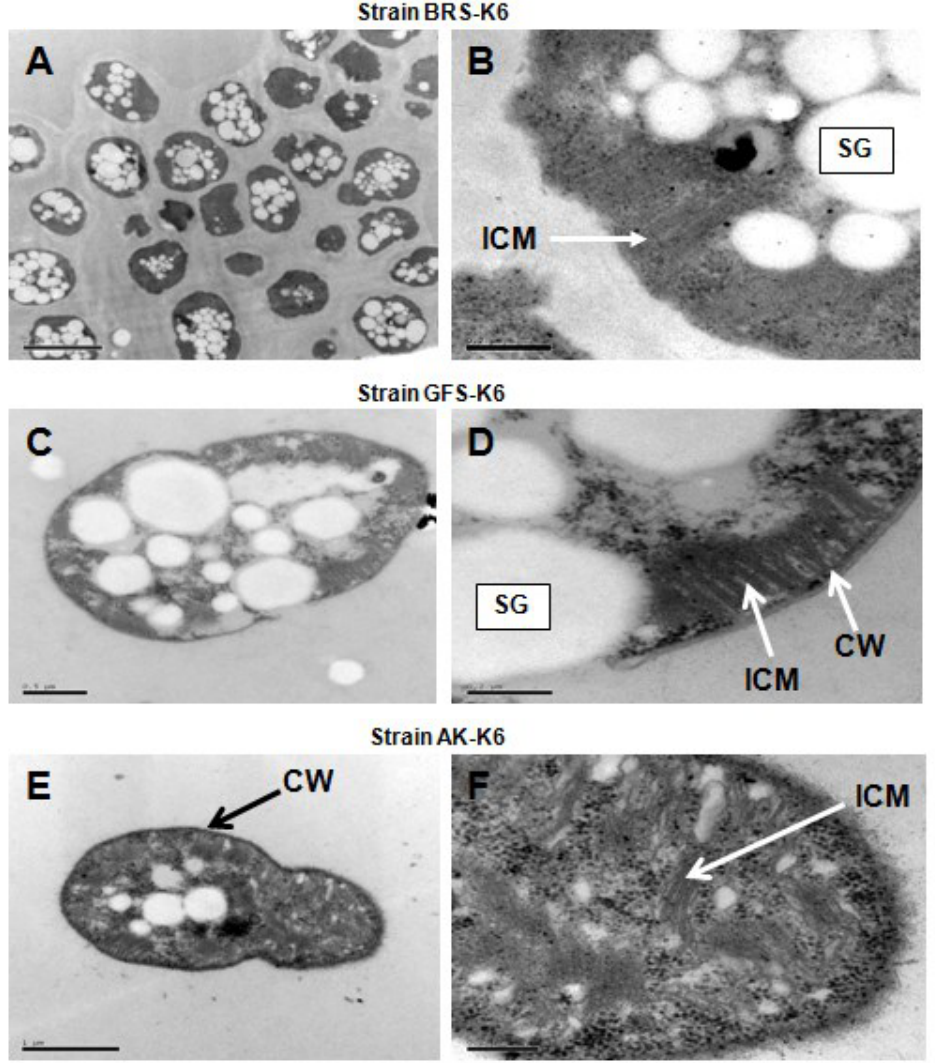
Figure 1. Transmission electron micrographs of thin sections of the three strains, which illustrates bundles of vesicular disks that are typical of gammaproteobacterial methanotroph intracytoplasmic membranes (ICM). Storage granules (SG) and a typical Gram-negative cell wall (CW). Bars, 2 μm ( A ), 0.2 μm ( B , D , F ), 0.5 μm ( C ), 1 μm ( E